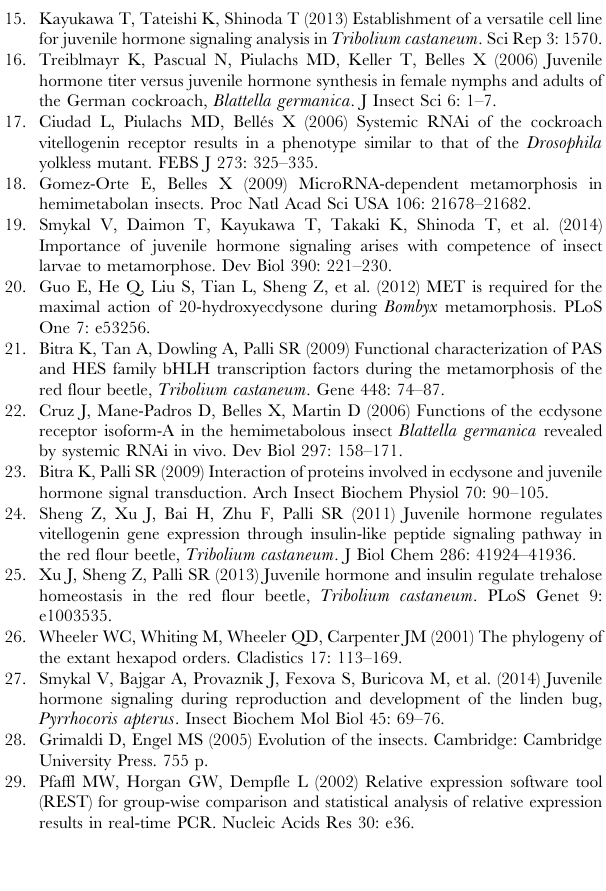
tabolous insects. PLoS One 6: e28728. 10. Charles JP, Iwema T, Epa VC, Takaki K, Rynes J, et al. (2011) Ligand-binding